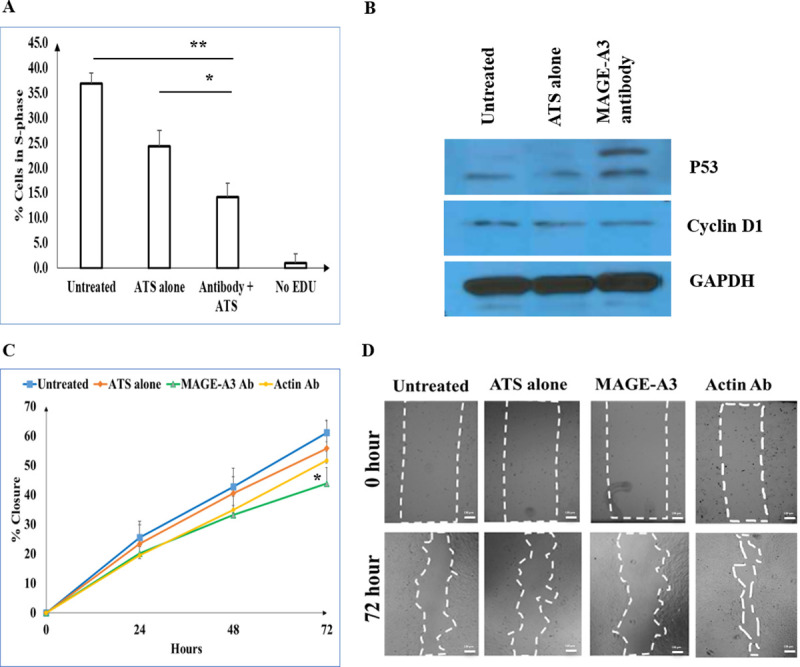
MAGE-A3 antibody treatment reduces the number of S-phase A431 cells, impedes cell migration in scratch assays, and increases p53 expression by interacting with MAGE-A3 proteins.(A) Percentage of A431 cells in S-phase in response to the following treatments: untreated, ATS alone, MAGE-A3 antibody + ATS, and untreated without EDU as a negative control. (B) Immunoblot of p53 and cyclin D1 expression in A431 cells subject to the following treatments: untreated, ATS alone and MAGE-A3 antibody. (C) Percentage closure in the different treatment groups over 72 hours. Actin antibody is used as an isotype control. The percentage closure in the group pre-treated with MAGE-A3 antibody was reduced after 72 hours compared with the untreated group (43.88±5.49% vs. 61.17±3.97% (p = 0.0058), respectively). (D) Light microscopy images of scratch closures between 0 and 72 hours in the noted treatment groups. Dotted lines highlight the wounded area. Scale bars indicate 100 μm. * and ** represent p<0.05.